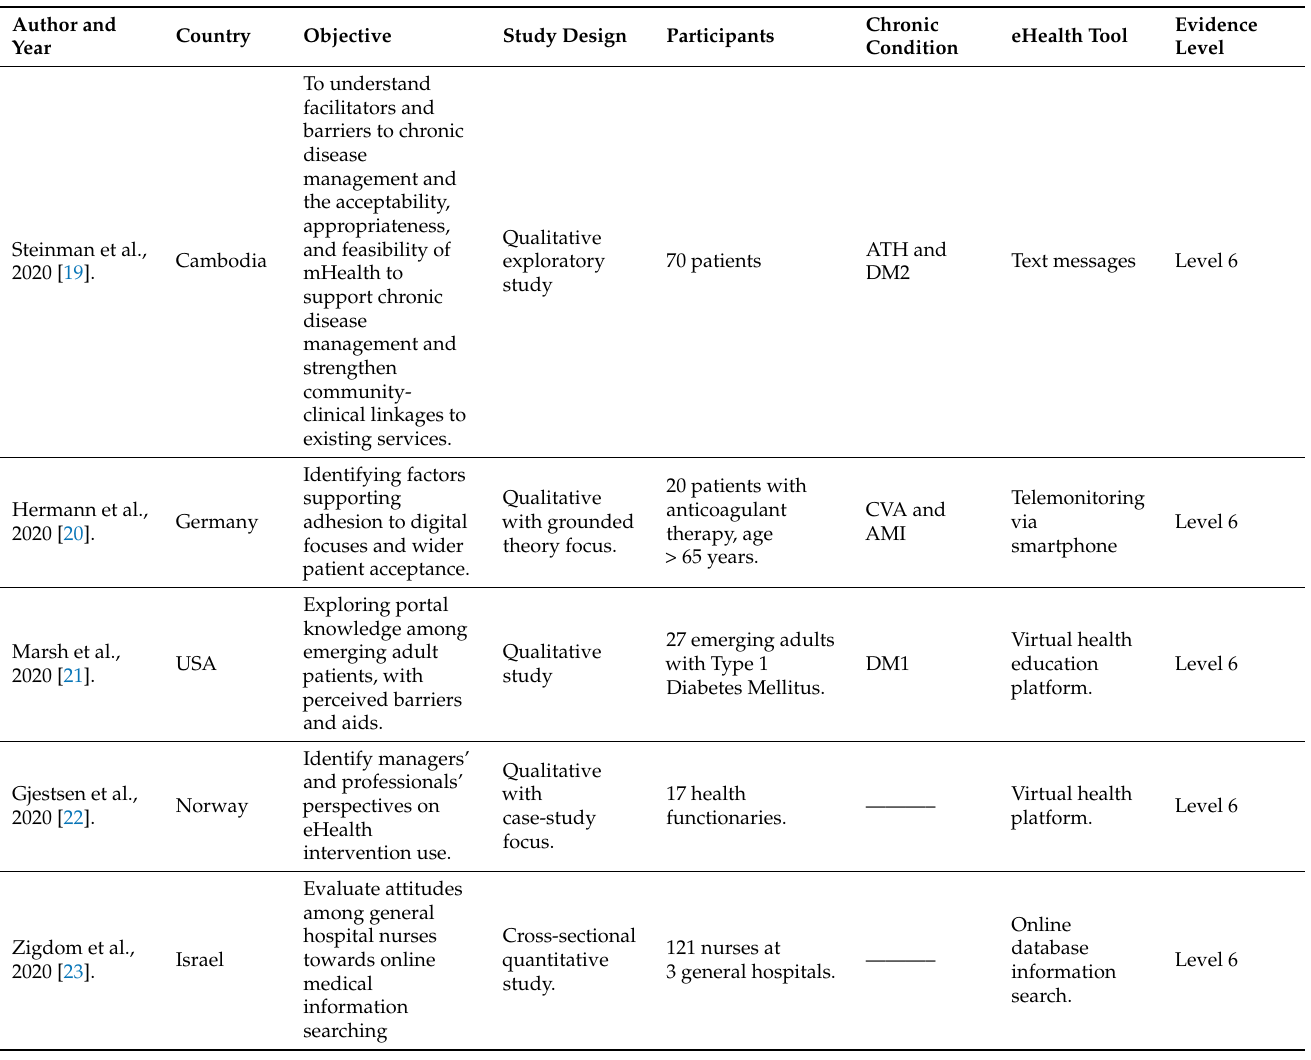
Table 1. Characterization of Selected